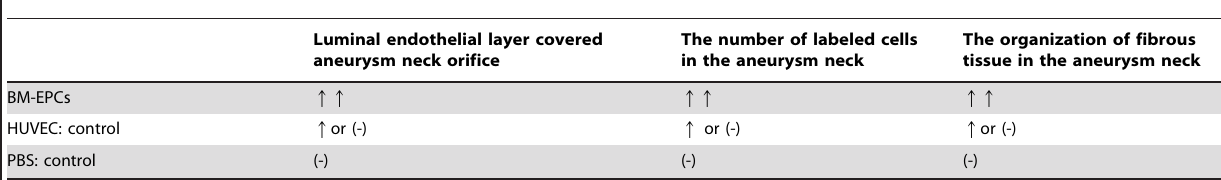
Table 1. The result of the luminal endothelial layer and the neck tissue HE staining in BM-EPC and control groups.